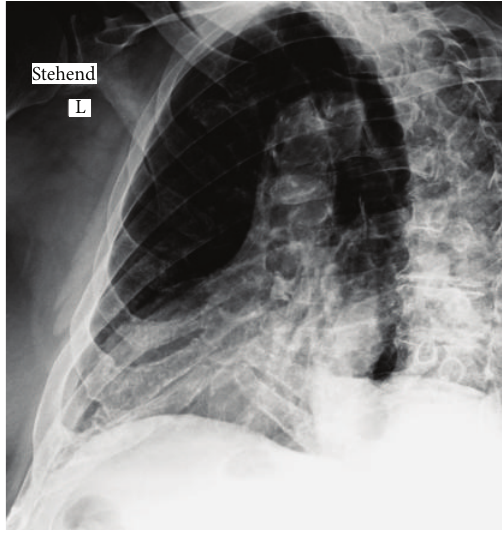
Figure 3: Extensive calcifications of the cartilaginous parts of the rib cage in an 85-year-old patient (suspected